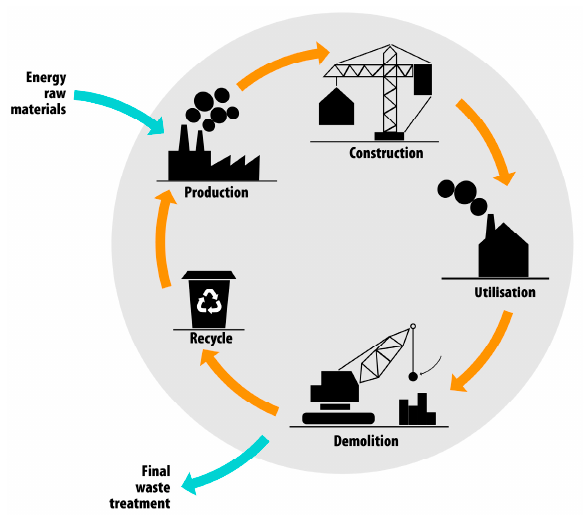
Figure 10. LCA cycle.